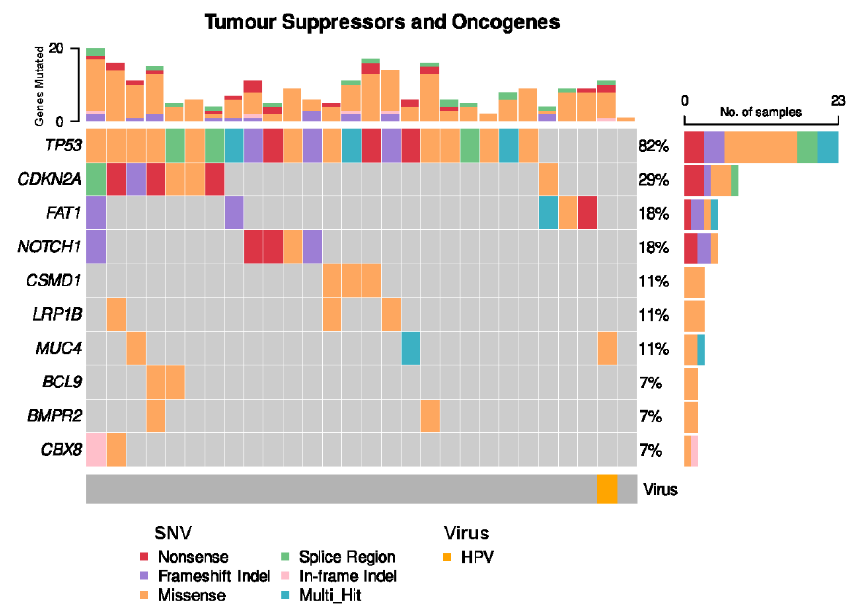
Figure 4. Frequent single nucleotide variants (SNVs) in patient cohort.